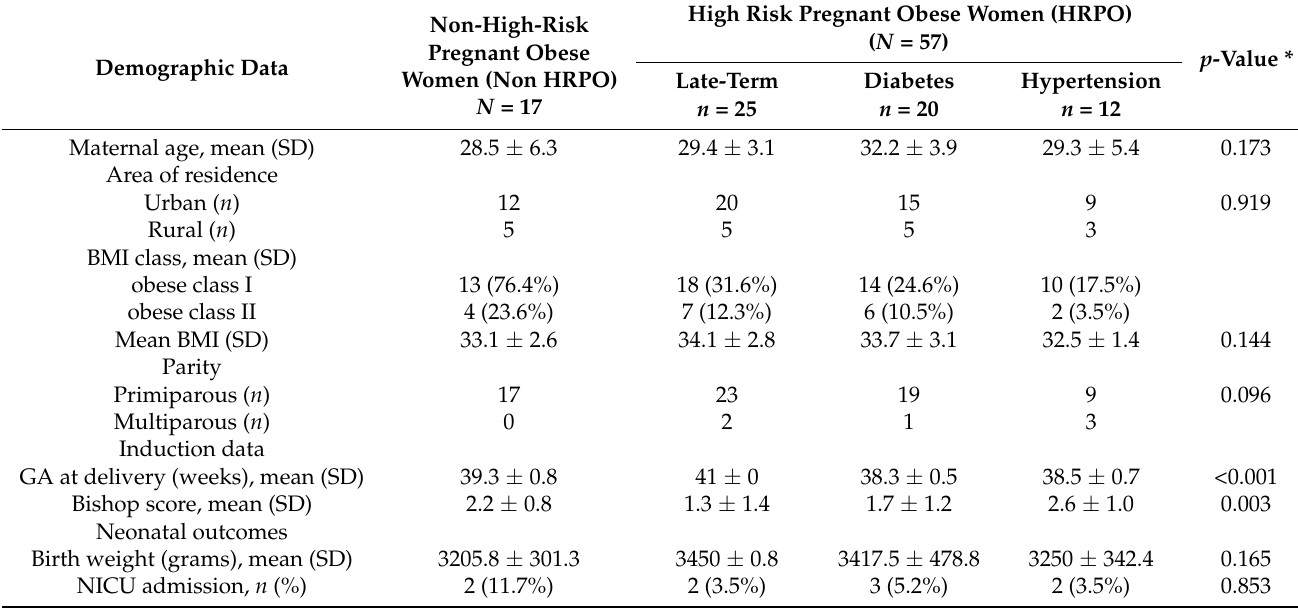
Table 2. Description of study participant group structure and